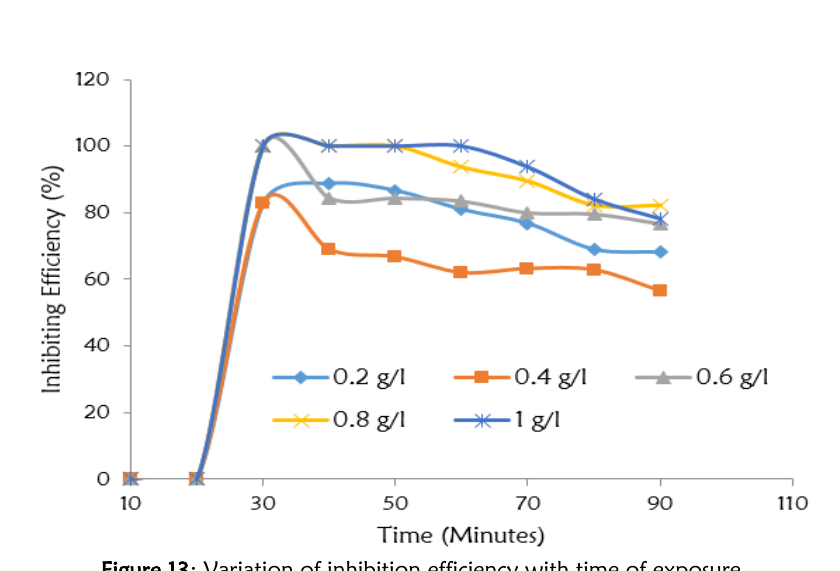
Figure 13: Variation of inhibition efficiency with time of